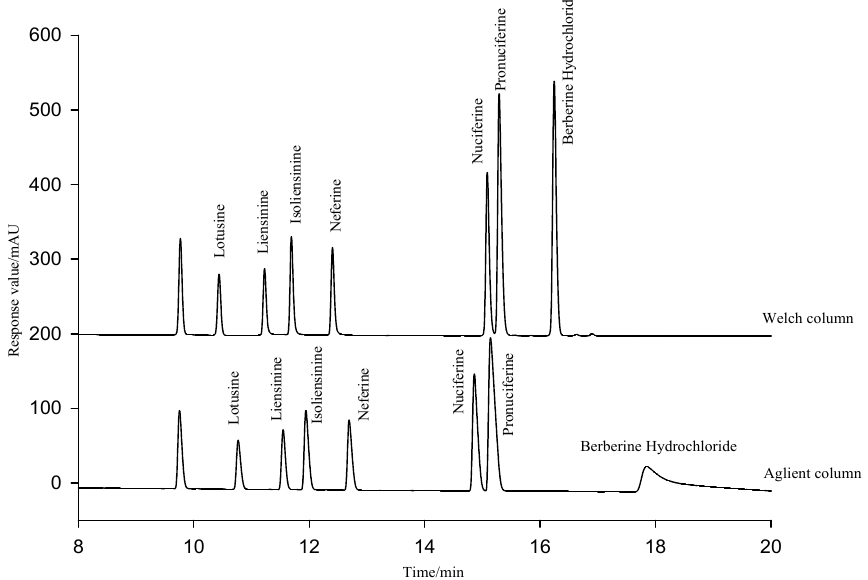
Figure 2. Chromatograms of different chromatographic columns.